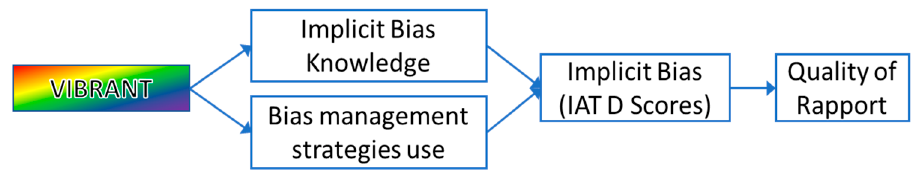
Figure 2. Theory of Change Model. IAT—Implicit Association Test